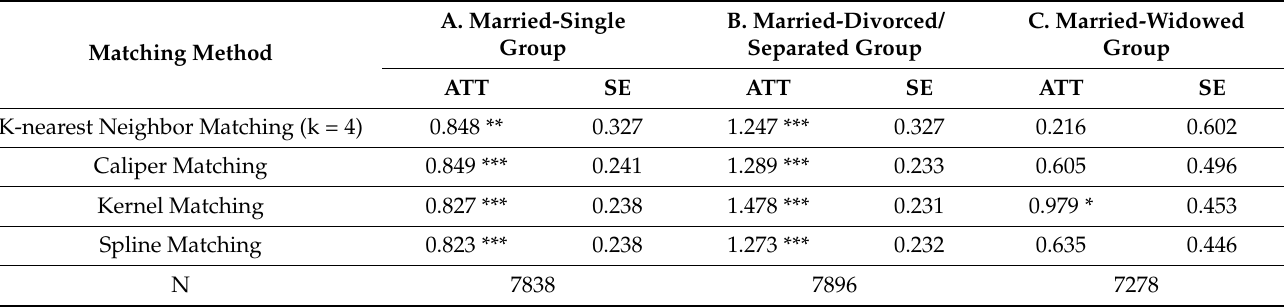
Table 2. Estimated average treatment effects on CESD-10 scores change in